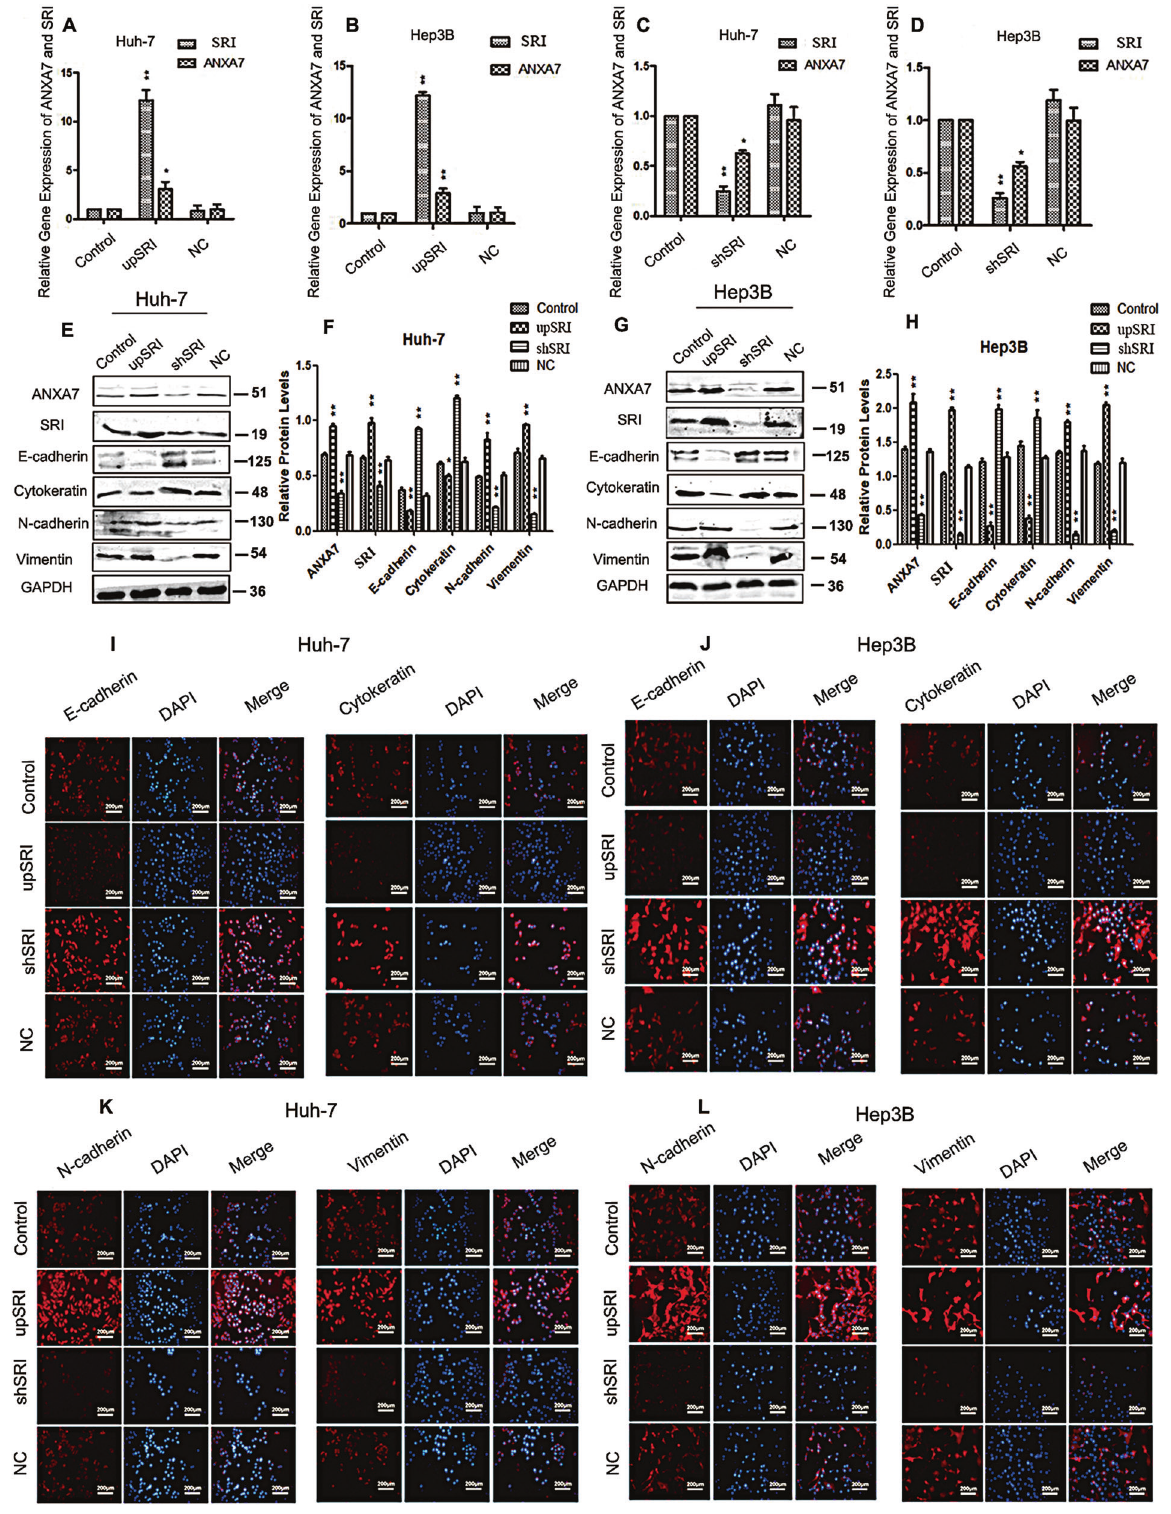
Fig. 6 The expression of ANXA7 and EMT indicators after upregulating and downregulating SRI. A – D When SRI is upregulated, the expression of ANXA7 increased signi fi cantly, while when SRI is downregulated, the expression of ANXA7 also decreased in Huh-7 and Hep3B cells by qRT-PCR (** p < 0.01, * p < 0.05). E – H When SRI is upregulated, the expression of ANXA7 increased, and promoted EMT, whereas when SRI is downregulated, the expression of ANXA7 also decreased, and inhibited EMT in Huh-7 and Hep3B cells by western blotting (** p < 0.01, * p < 0.05). I , J IF was used to detect the E-cadherin and Cytokeratin after upregulating and downregulating SRI. K , L IF was used to detect the N-cadherin and Vimentin in Huh-7/Hep3B cells after upregulating and downregulating